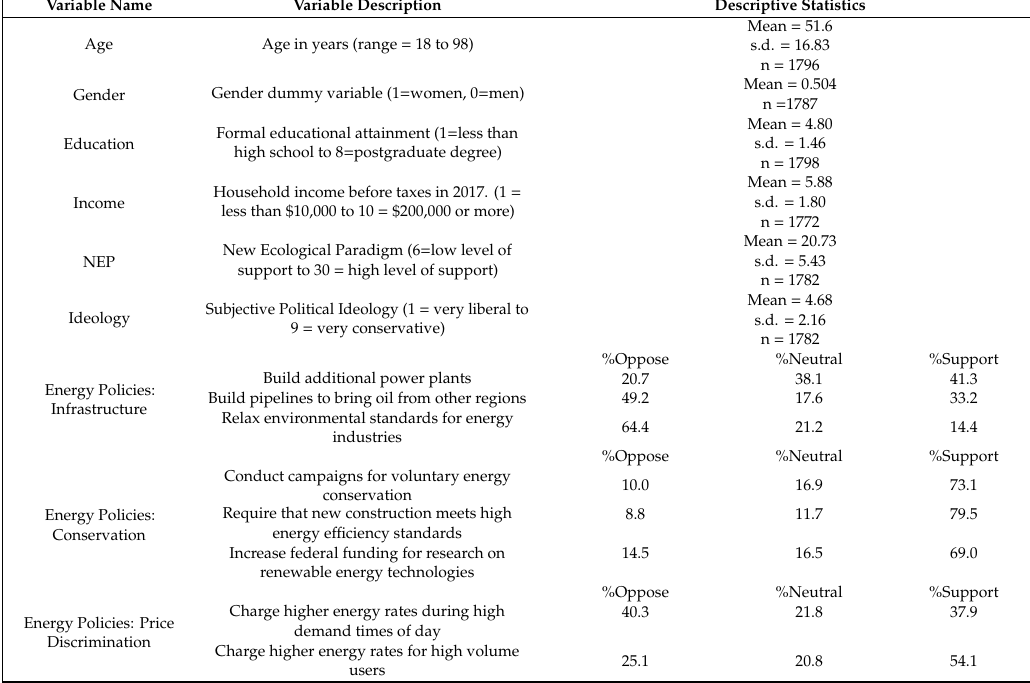
Table 3. Descriptive